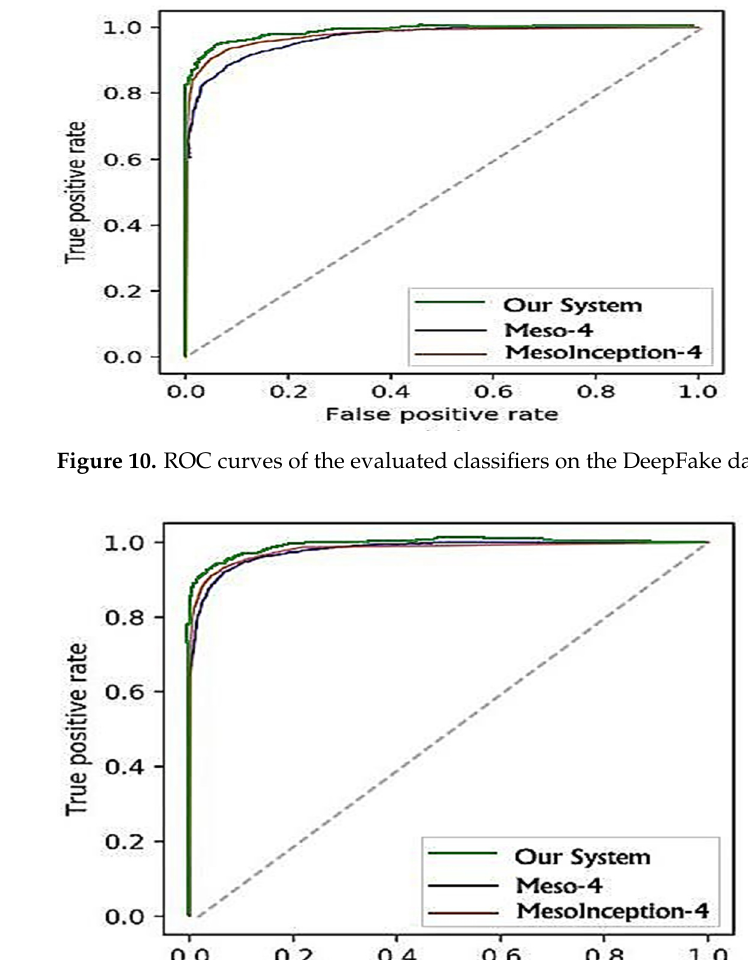
Table 5. Face2face classification scores evaluation.